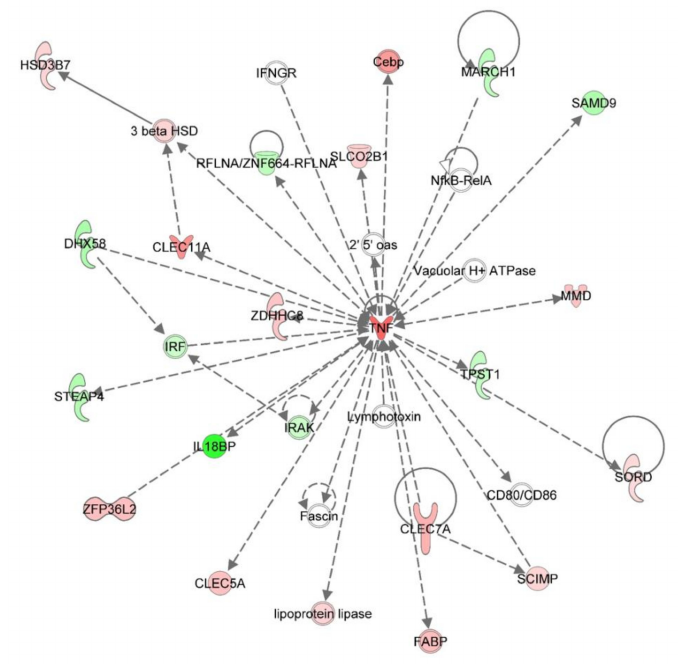
Figure 4. PRRSV-induced changes in the c-type lectin receptor signaling system of alveolar macrophages. Red molecules are significantly upregulated in PRRSV-infected macrophages relative to mock-infected cells and green molecules are downregulated in at least one time point (12, 24, and 48 hpi). White molecules were not significantly ( p > 0.05) di ff erent between the two